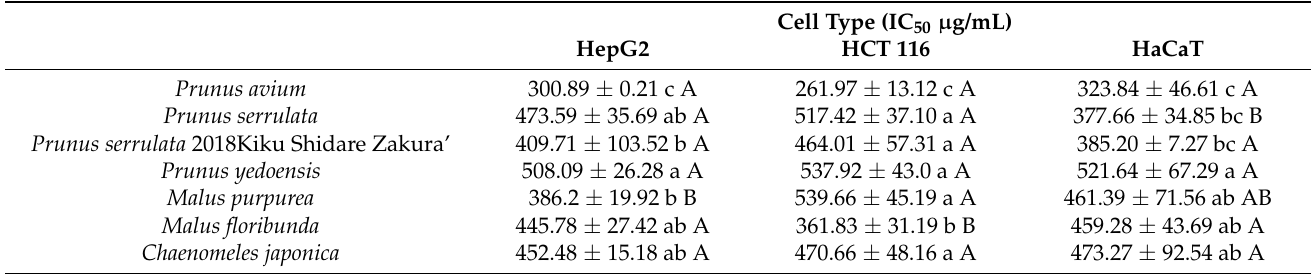
Table 4. In vitro antiproliferative activity (IC 50 expressed in µ g/mL) of Rosaceae inflorescence exstracts tested on hepatocellular carcinoma (HepG2), colorectal cancer (HCT 116) and keratinocyte (HaCaT) cell